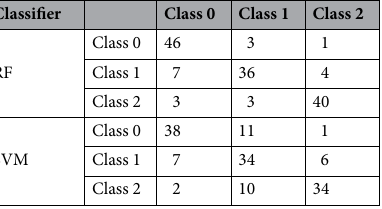
Table 4. Classification results, expressed as a confusion matrix, for the three-groups comparison with the two tested classifiers.